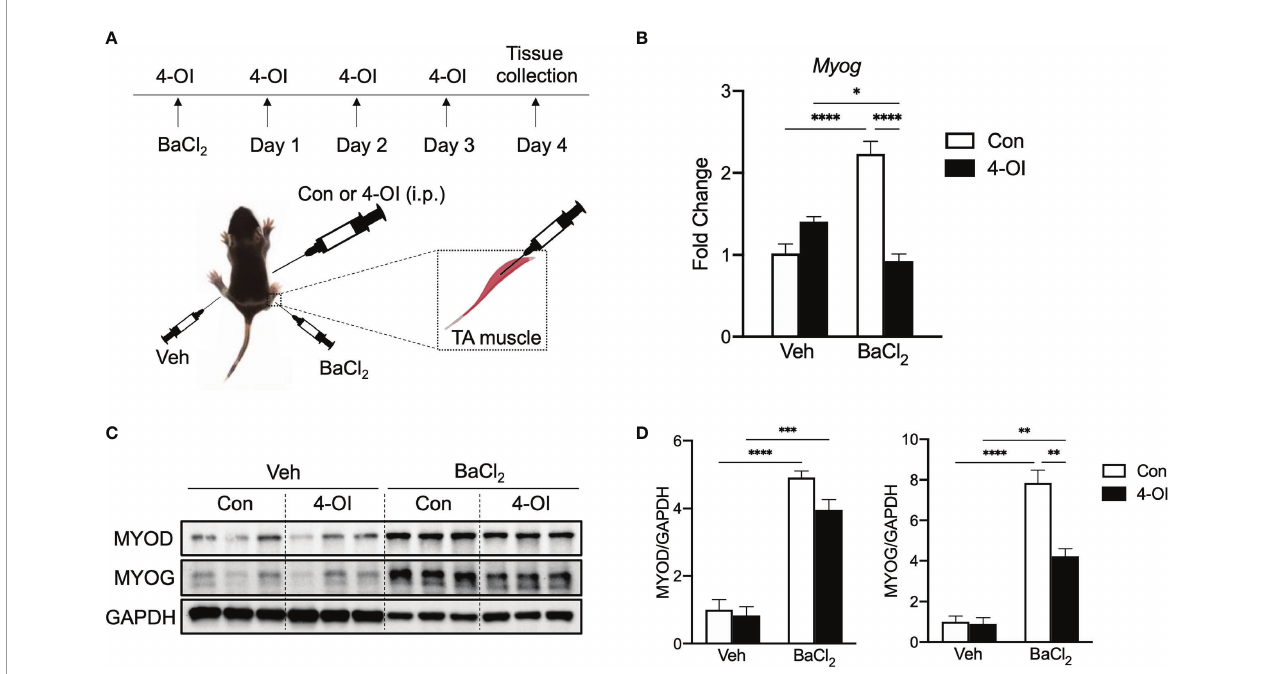
FIGURE 6 | 4-OI suppresses gene and protein expression of MYOG in muscle after injury. (A) Experimental scheme of muscle injury in mice. (B) Fold change of Myog mRNA expression at day 4 of muscle injury by barium chloride (BaCl 2 ) with or without 4-OI (n = 4). (C) Western blotting data showing differences in myogenic transcription factor expression between vehicle (Veh) treated groups and BaCl 2 treated groups with or without 4-OI. (D) Quanti fi cation of MYOD and MYOG. * denotes p< 0.05, ** p <0.01, *** p <0.001, **** p <0.0001 based on one-way